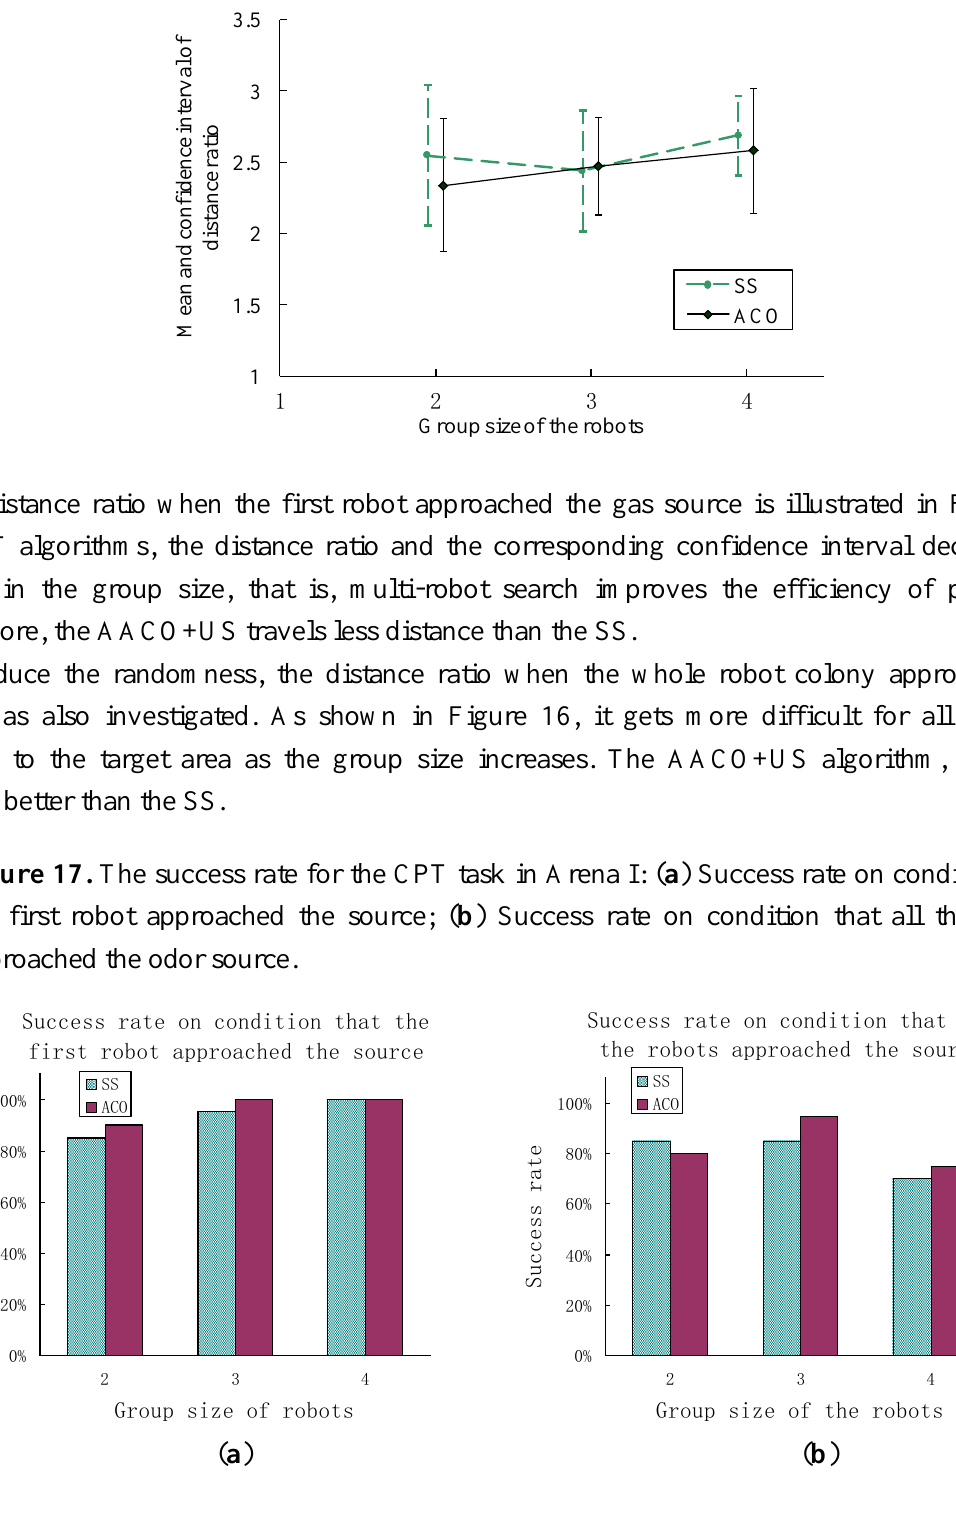
Figure 16. The mean value and confidence interval of distance ratio on condition that the whole robots colony approached the gas source.